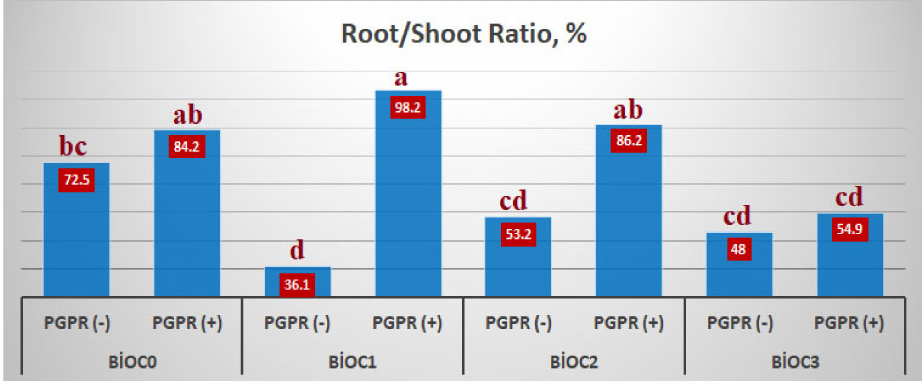
Figure 3. Effect of BxP interaction on root–shoot ratio (R/S): PGPR(+); PGPR(+):Inoculation; PGPR(- ):Non-inoculation; BioC 0 : 0% biochar; BioC 1 : 2.5% biochar; BioC 2 : 5% biochar; BioC 3 : 10% biochar; R/S LSD(0.05) : 0.233. Means followed by different letters are statistically different from each other according to Duncan’s Multiple Range test at p ≤ 0.05.